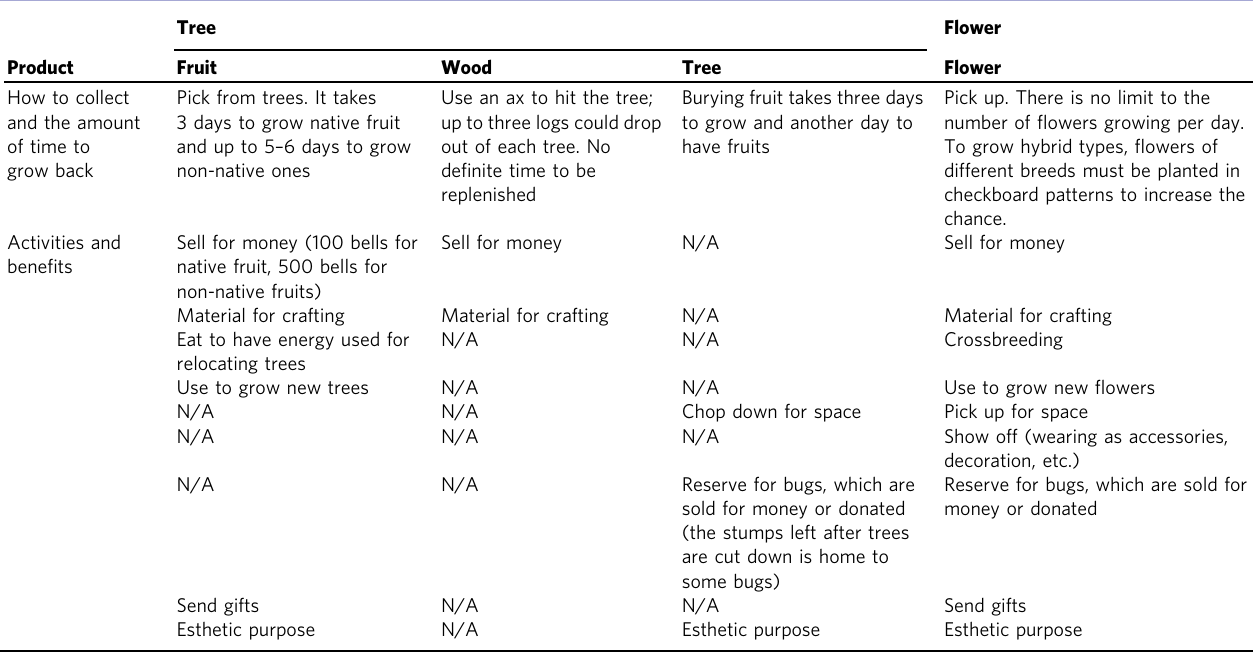
Table 1 Bene fi ts and purposes of planting trees and fl owers.